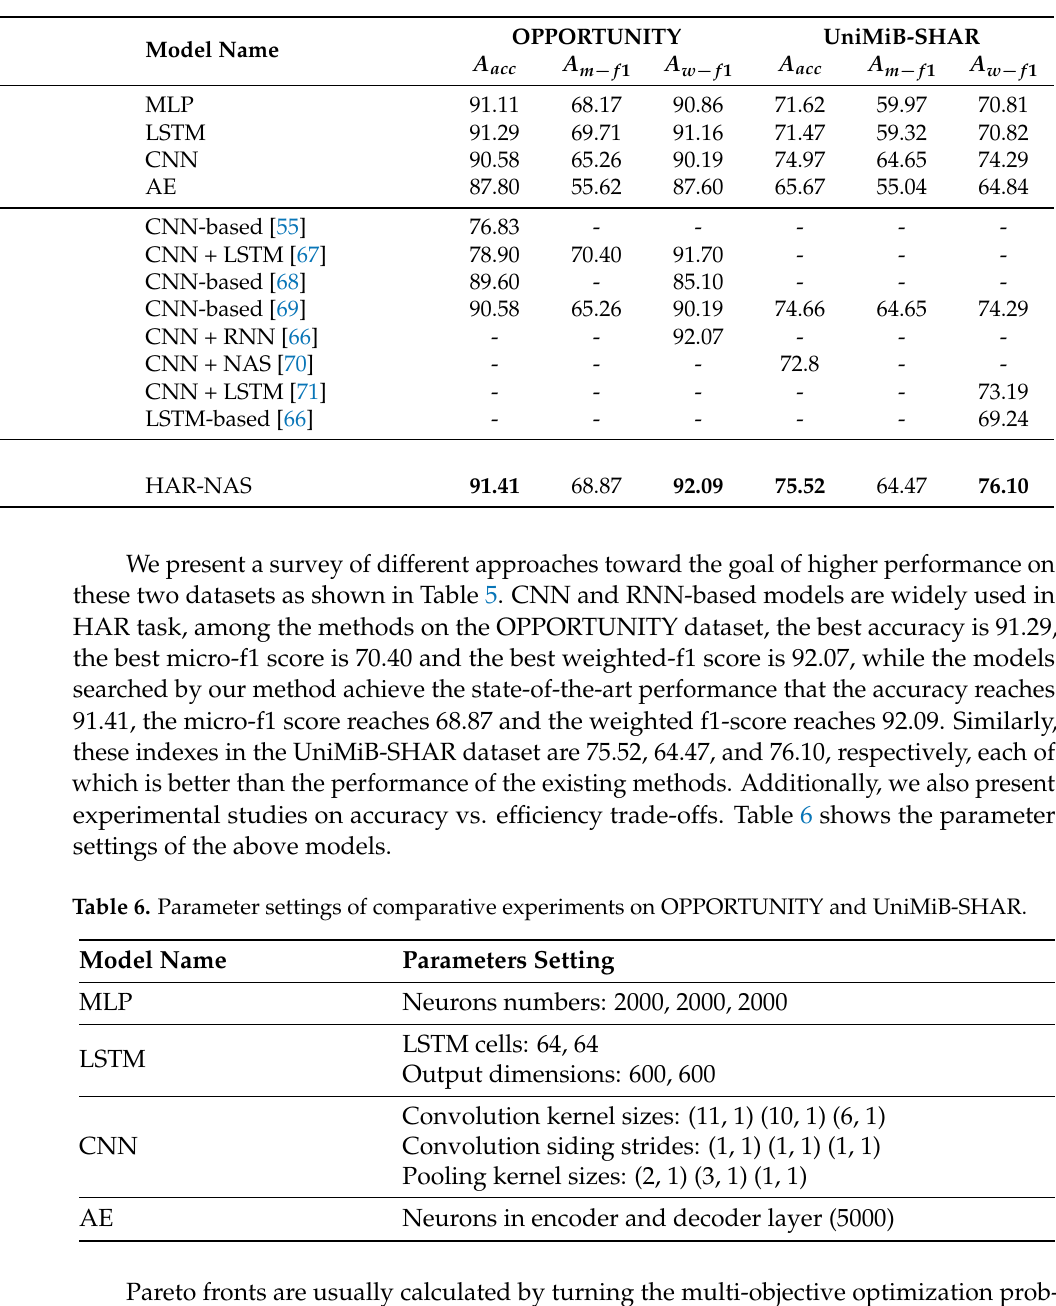
Table 5. Performance of comparative methods and the proposed NAS model on datasets OPPORTU- NITY and UniMiB-SHAR.